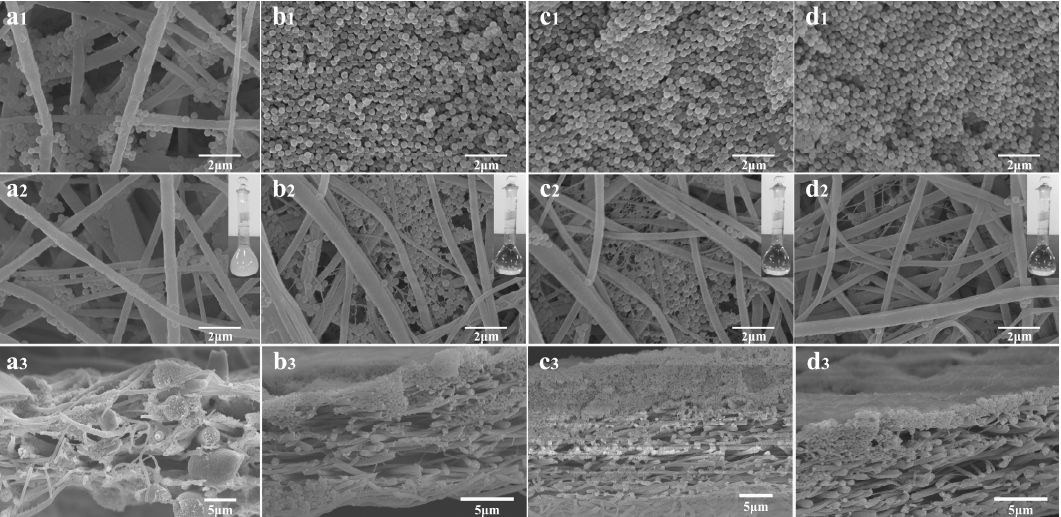
Figure 5. FE ‐ SEM images of the top surface, bottom surface and cross ‐ section of the membranes after a filtration test: ( a1 – a3 ) PVDF ‐ NMs; ( b1 – b3 ) PVDF ‐ TLNMs ‐ 1; ( c1 – c3 ) PVDF ‐ TLNMs ‐ 2; ( d1 – d3 ) after a filtration test: ( a1 – a3 ) PVDF-NMs; ( b1 – b3 ) PVDF-TLNMs-1; ( c1 – c3 ) PVDF-TLNMs-2; PVDF ‐ TLNMs ‐ 3 (inset: photographs of the filtrate solutions). ( d1 – d3 ) PVDF-TLNMs-3 (inset: photographs of the filtrate solutions). Table 2. The physical properties and filtration results for PVDF ‐ NMs and PVDF ‐ TLNMs. Table 2. The physical properties and filtration results for PVDF-NMs and PVDF-TLNMs.